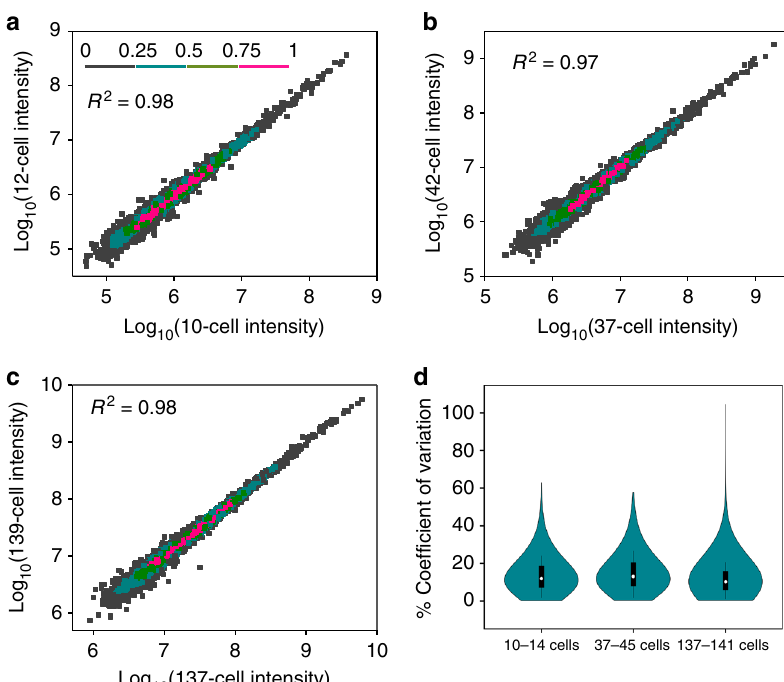
Fig. 4 Label-free quanti fi cation reproducibility. Pairwise correlation of protein LFQ intensities between ( a ) 10-cell and 12-cell samples, ( b ) 37-cell and 42- cell samples, ( c ) 137-cell and 141-cell samples. Data point densities are color-coded as shown in ( a ). d Violin plot showing the distributions of coef fi cients of variation of protein LFQ intensities for the three cell loading groups. Center lines show the medians; box limits indicate the 25th and 75th percentiles as determined by R software; whiskers extend 1.5 times the interquartile range from the 25th and 75th